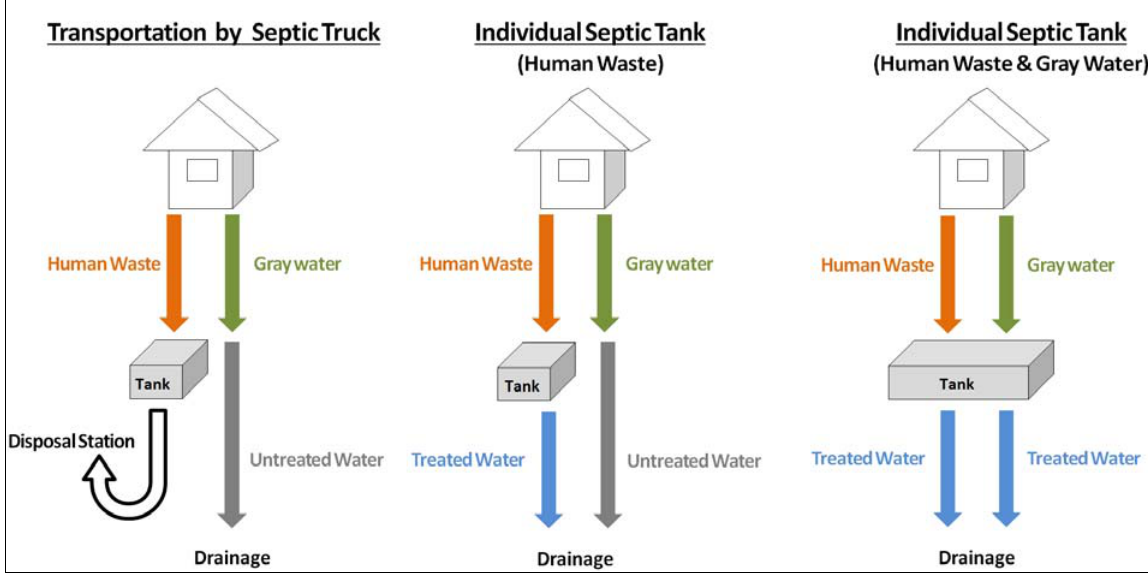
Figure 8. The three methods of domestic wastewater treatment utilized in areas not connected to municipal sewerage systems.